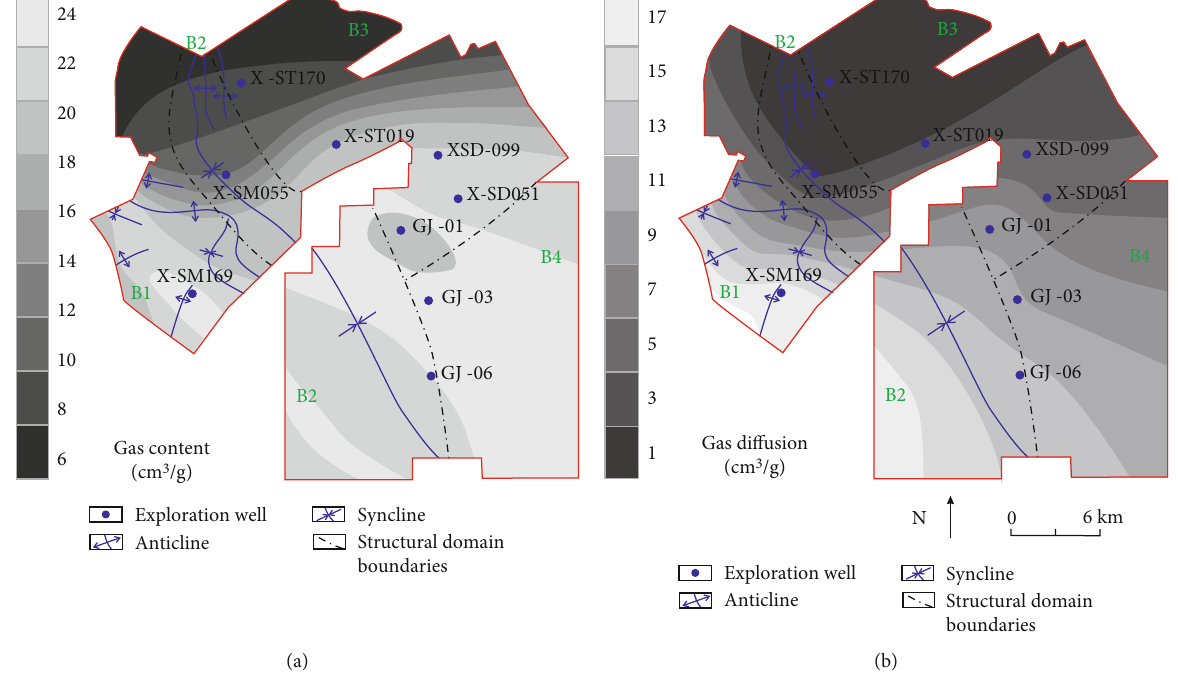
Figure 14: Distribution characteristics of gas content (a) at the end of Cretaceous and gas di ff usion during substage V